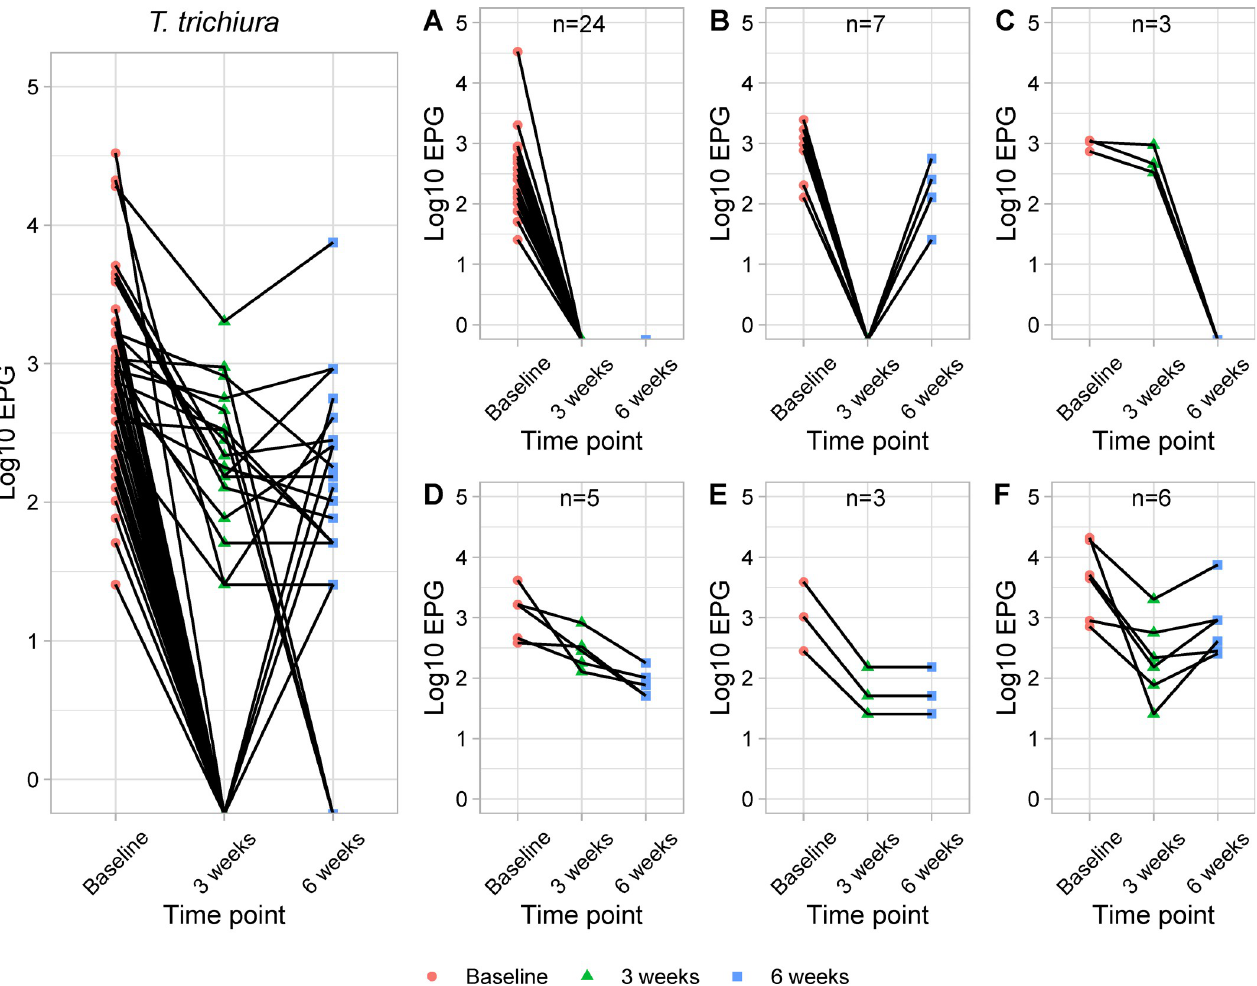
Fig 3. T . trichiura infection patterns over the three time points among T . trichiura positive participants at baseline (N = 48). Different patterns of T . trichiura infection were observed among 48 infected participants following 3 doses of albendazole treatment: (A) Overall T . trichiura infection patterns over 3 time points (n = 48). (B) cured from infections at 3 weeks and remain negative at 6 weeks (n = 24), (C) cured from infections at 3 weeks post-treatment but increased of egg output at 6 weeks post-treatment (n = 7), (D) egg output was reduced at 3 weeks post-treatment and become negative at 6 weeks post- treatment (n = 3), (E) showed reduction of egg output following treatment (n = 5), (F) showed reduction of egg output at 3 weeks post-treatment and remain unchanged at 6 weeks post-treatment (n = 3), (G) showed increment of egg output at 6 weeks post-treatment after a reduction at 3 weeks post-treatment (n = 6).